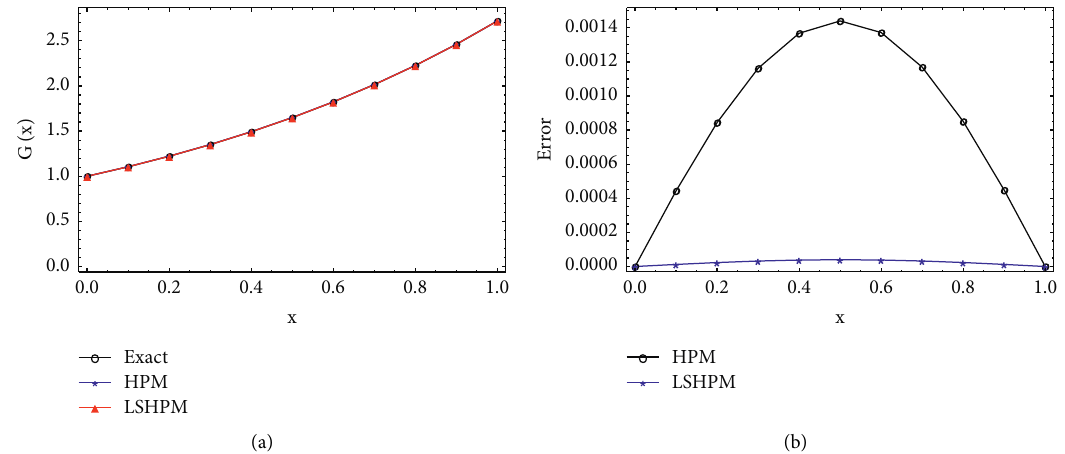
Figure 10: Graphical representation of solutions and errors in Problem 10. (a) Comparison of Exact, HPM, and LSHPM solutions. (b) Comparison of absolute errors of HPM and LSHPM.